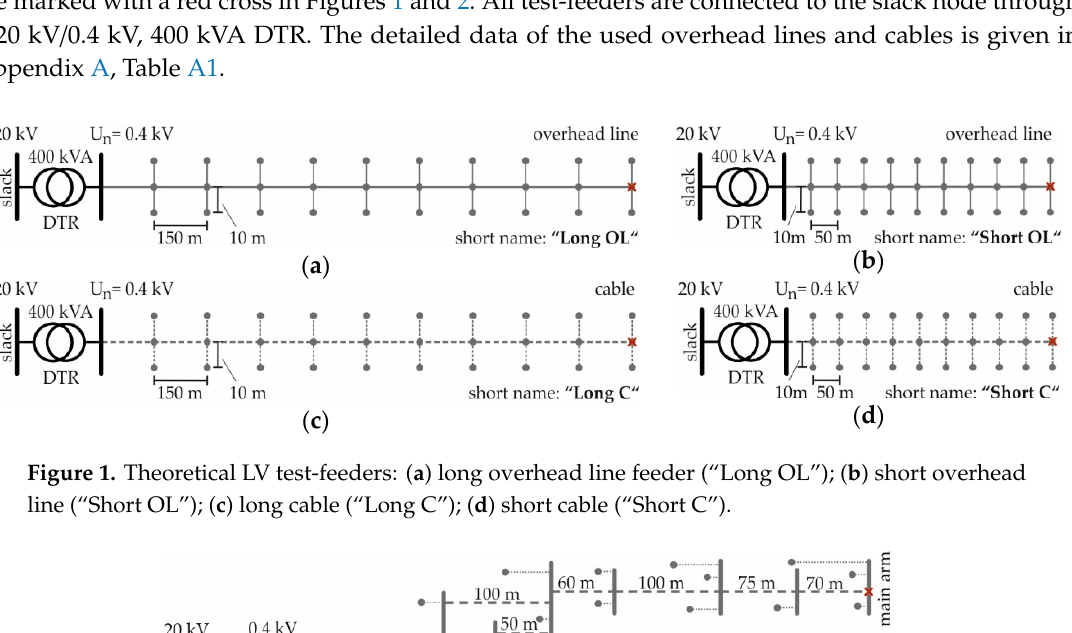
Figure 2. Real LV test-feeder: branched cable (“Branched C”).